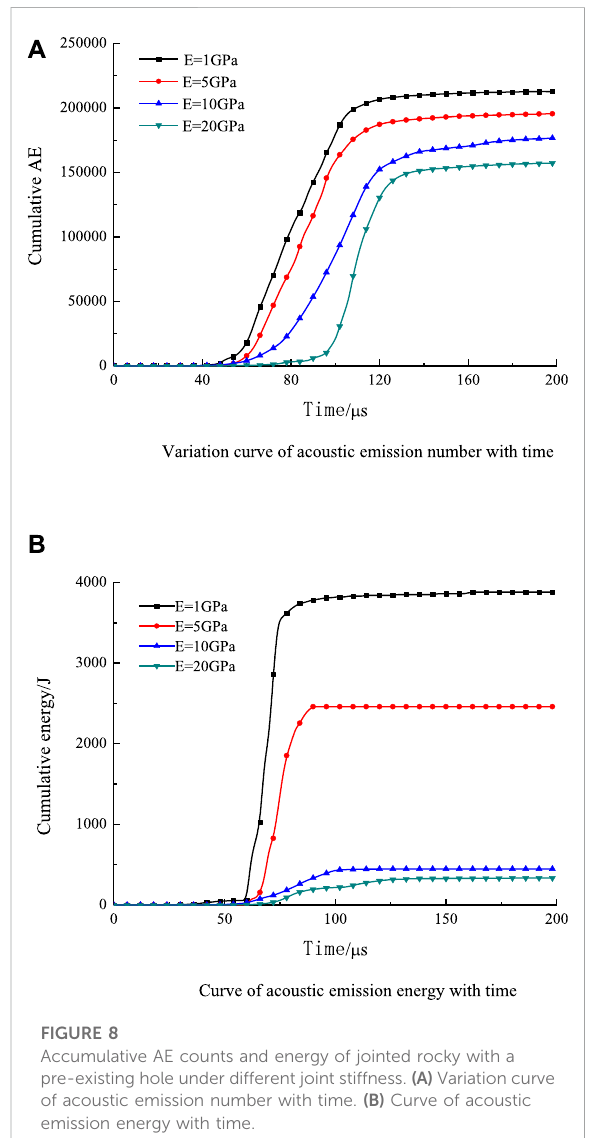
FIGURE 8 Accumulative AE counts and energy of jointed rocky with a pre-existing hole under different joint stiffness. (A) Variation curve of acoustic emission number with time. (B) Curve of acoustic emission energy with time.